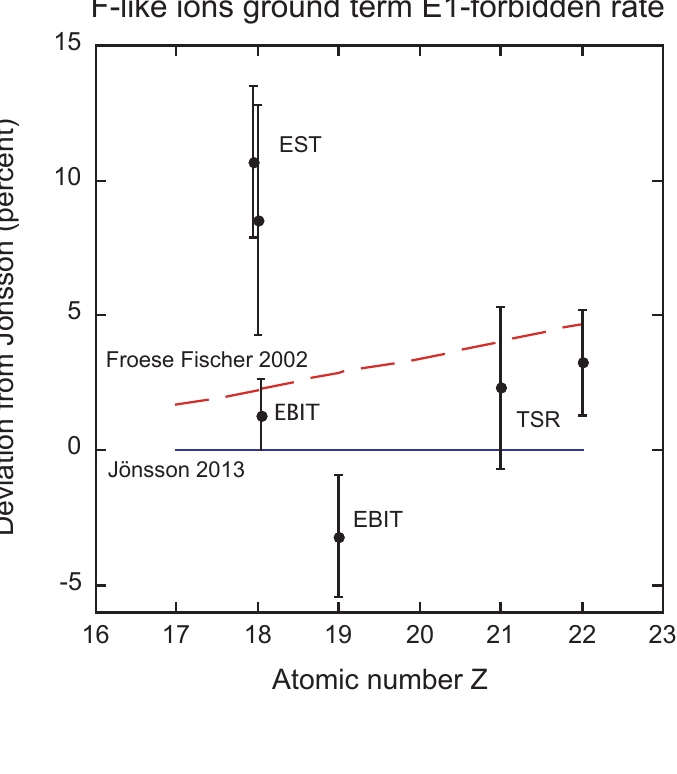
Figure 9. Lifetime of the 2s 2 2p 5 2 P o level in F-like ions from Cl through Ti. Measurements 1 / 2 (full markers with error bars) have been done at an electrostatic ion trap (EST) (Ar), at the Livermore EBIT (Ar, K), and at the TSR heavy-ion storage ring (Sc, Ti). Two of the more recent computations are shown; the experimental errors are still too large to discriminate among these two